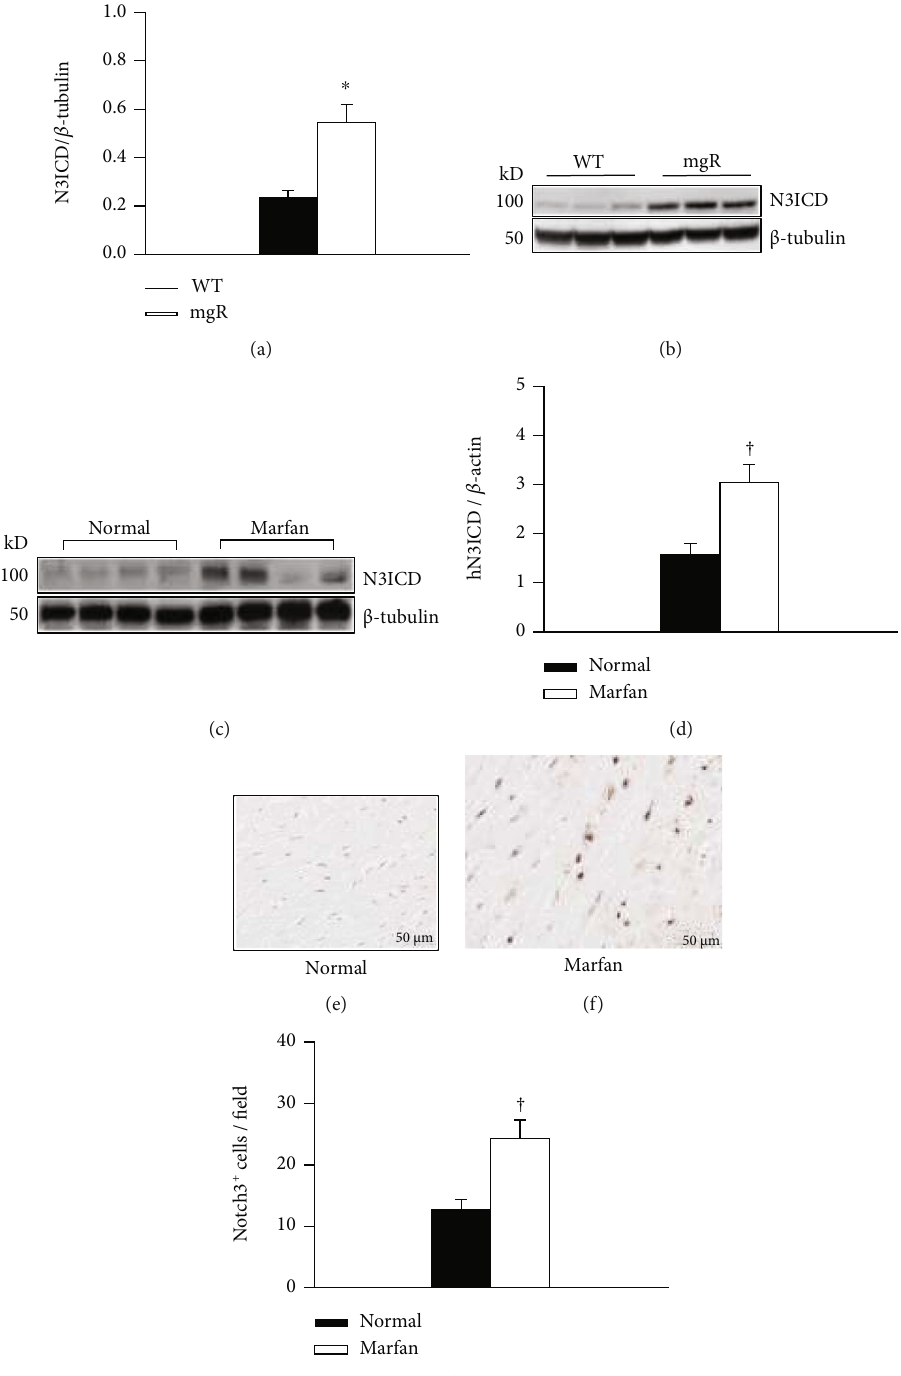
Figure 2: Notch3 activation was increased in the aorta of Marfan patients and Fbn1 mgR/mgR (mgR) mice. Western blot analysis of active Notch3 (N3ICD) levels was performed on aortic protein from WT and mgR mice at PD28 (a) ( n = 8 /group) and Marfan patients and normal controls ( n = 10 /group) (c). The bar graphs show relative N3ICD levels in mouse (b) and human aortic tissue (d), respectively. ∗ P < 0 : 05 compared to WT controls; † P < 0 : 01 compared to normal controls; Student ’ s t -test. Immunohistochemical staining of human Notch3 in the aortic sections from normal control (e) and Marfan patients (f) ( n = 6 /group). Positive staining is shown in brown (DAB). Notch3-positive cells were counted (cells/high power fi eld, 40x). (g) The values re fl ect the mean ± SE . † P < 0 : 01 compared to normal control; Student ’ s t